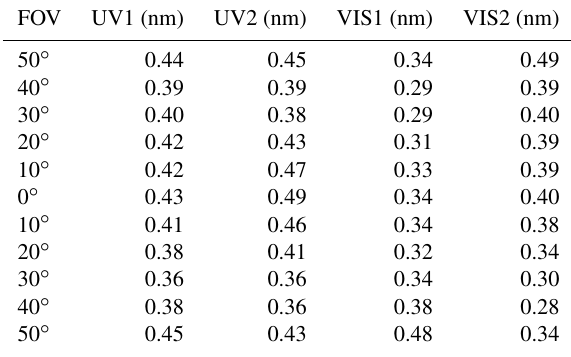
Figure 3. Spectral calibration in the spatial dimension. Table 4. FWHM of the